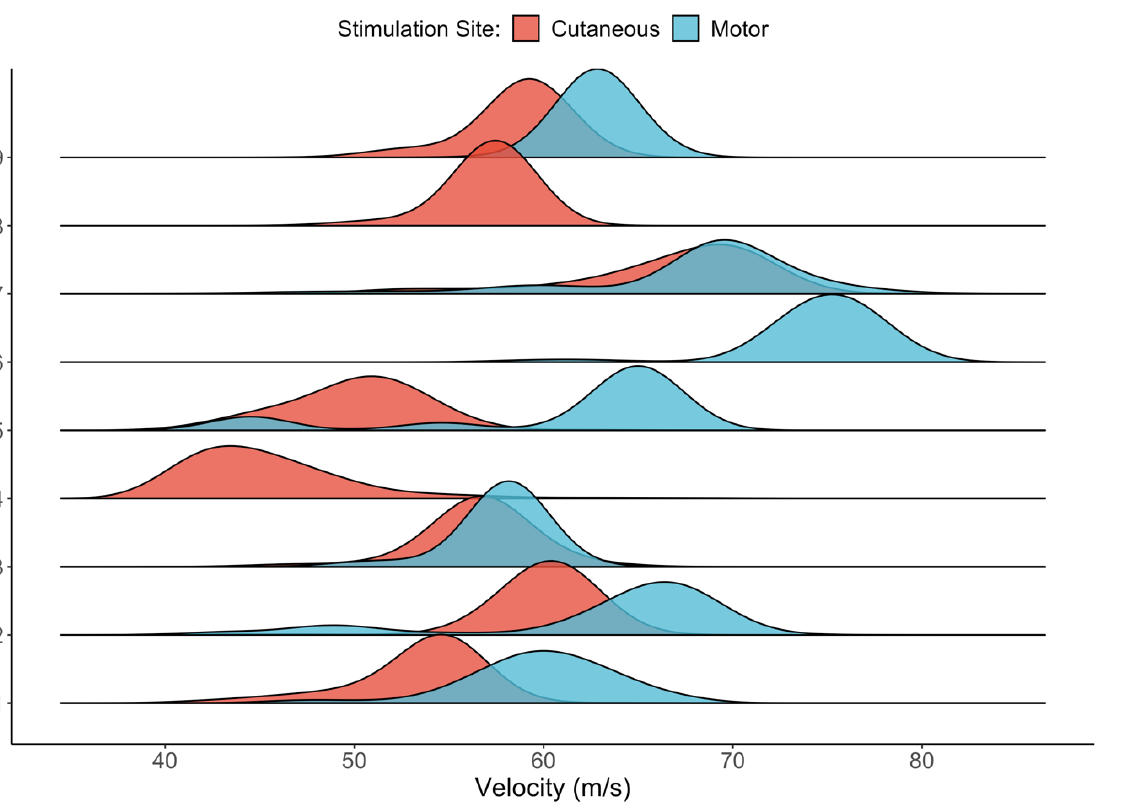
Figure 3. Density estimates of fast fibre (Aβ group), extracted from the intrinsic velocity spectrum (IVS) for each animal and stimulation site.